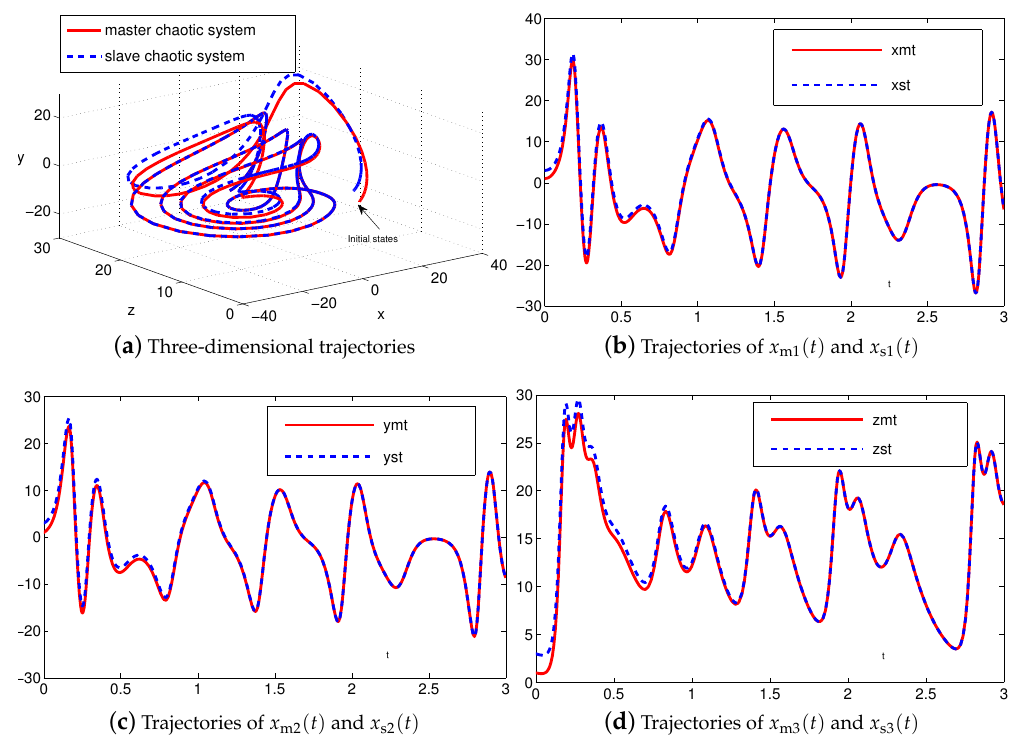
Figure 6. Synchronization performance between two identical autonomous chaotic systems (27) and (28) equipped with controller (6) via the proposed SEZN